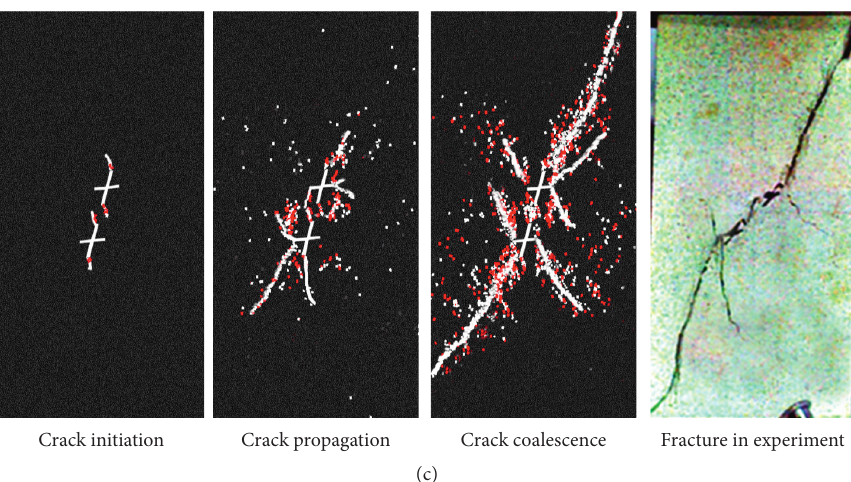
Figure 14: Diagram of crack propagation process shown by simulation results at different k values and the experimentally obtained results: